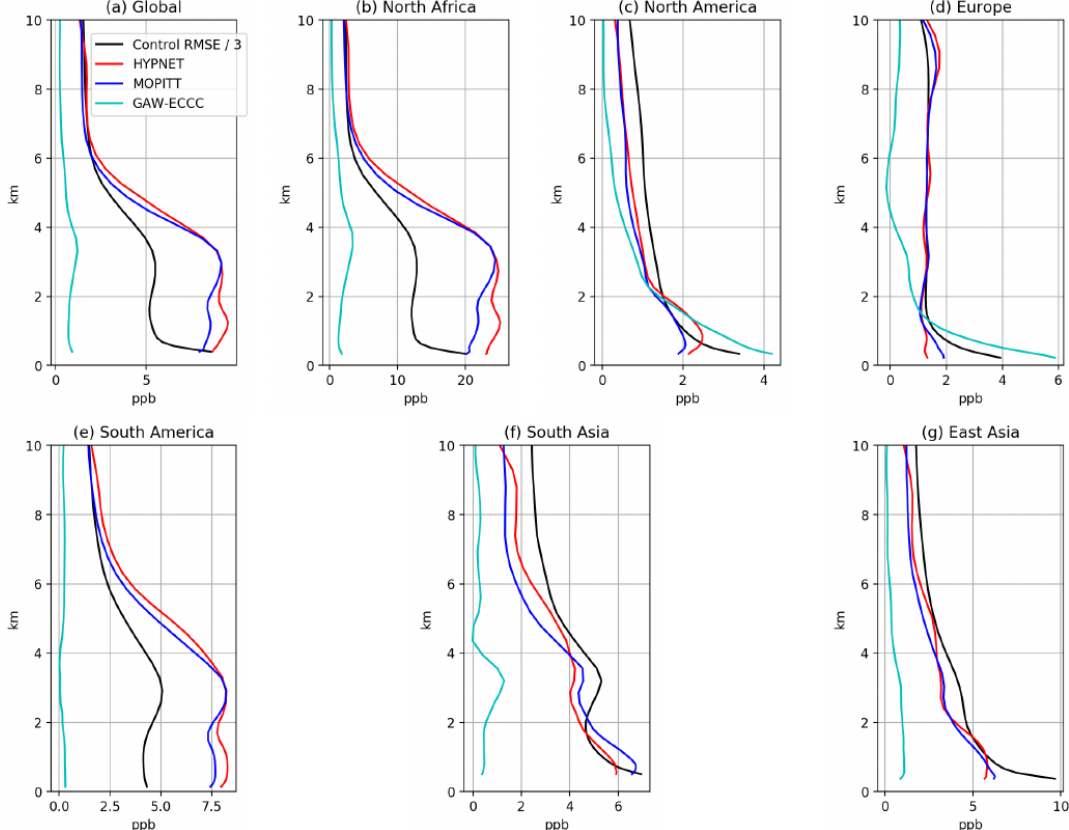
Figure 11. Profiles of the benefit and control RMSE averaged over different domains. In each panel, the black curve shows the control RMSE scaled down by a factor of 3. The colored curves show the benefits due to the assimilation of three different observational networks ( EXP_HYP , EXP_MOP and EXP_GAW ). Panel (a) shows the globally averaged profiles. The other panels show profiles averaged over the domains shown in Fig. 9a. The limits on the x axis are different in each